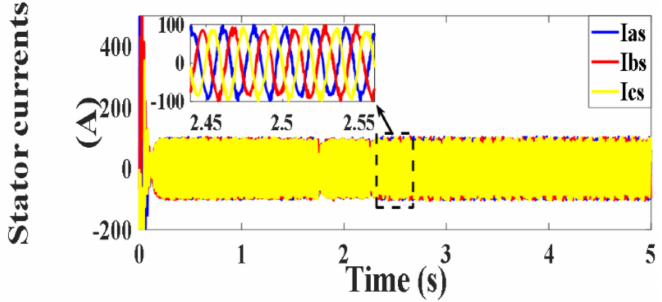
Figure 56. Stator currents under PVC (A).